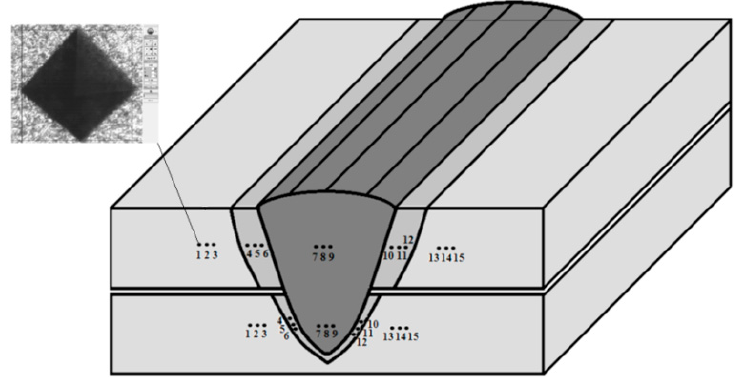
Figure 5. Hardness test point distributions in the lap joint.